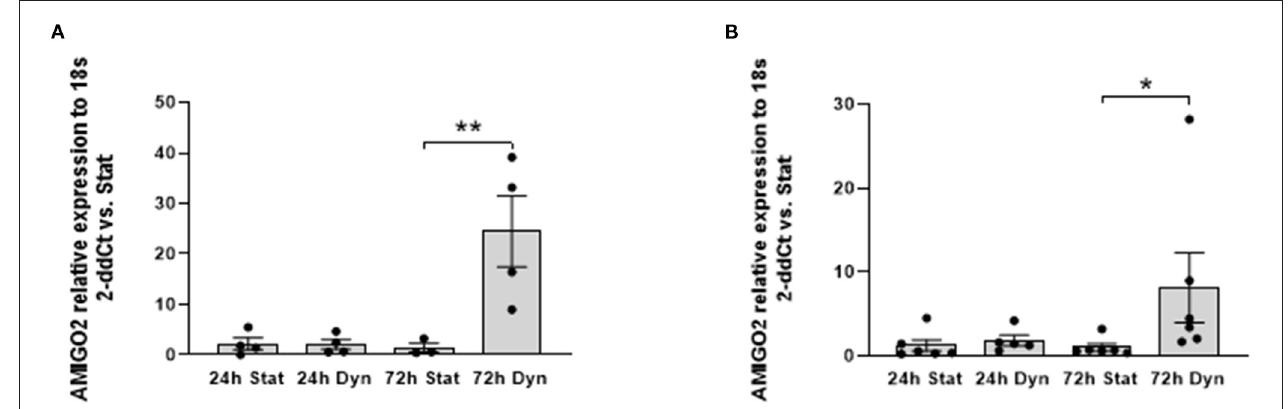
FIGURE 3 | RNA-seq validation. Bar graphs showing relative expression of AMIGO2 in SVPs after mechanical stimulation assessed by real-time qPCR. (A) Analysis performed in the same samples of the RNA-Seq ( N = 5); difference among groups are evaluated using one-way ANOVA for normal distributed values, based on the result of normality tests. (B) Analysis performed using SVPs obtained from a new set of donors ( N = 7), statistical analysis conducted using Kruskal–Wallis test for not normal distributed values, based on results from normality tests. Data are presented as mean ± SEM of 2-ddCt vs static (Stat) condition of each time point, * p < 0.05 ** p < 0.01 ( t -test stat vs. dyn).